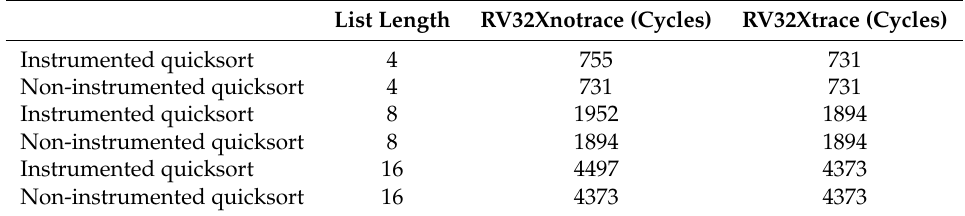
Table 2. Number of cycles of execution of both instrumented and non-instrumented quicksort algorithm and with lists of different lengths on both RV32Xnotrace and